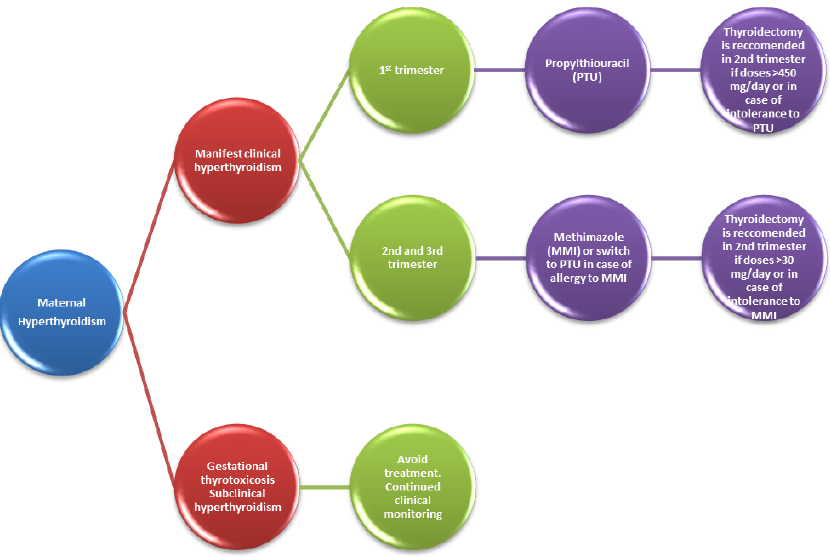
Figure 2. Pharmacotherapeutic management in maternal hyperthyroidism.